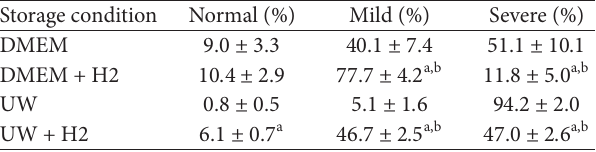
Table 2: Proportionofeach gradeof chondrocyteinpreserved OCT